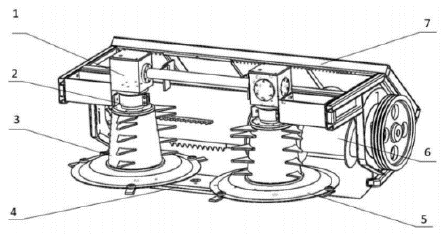
Figure 7. Structure diagram of feeding device of hairy vetch harvester. 1, Bevel gear transmission case; 2, Bearing chamber; 3, Vertical drum; 4, Multi-gear transmission box; 5, Cutting device; 6, Spiral conveyor; 7,